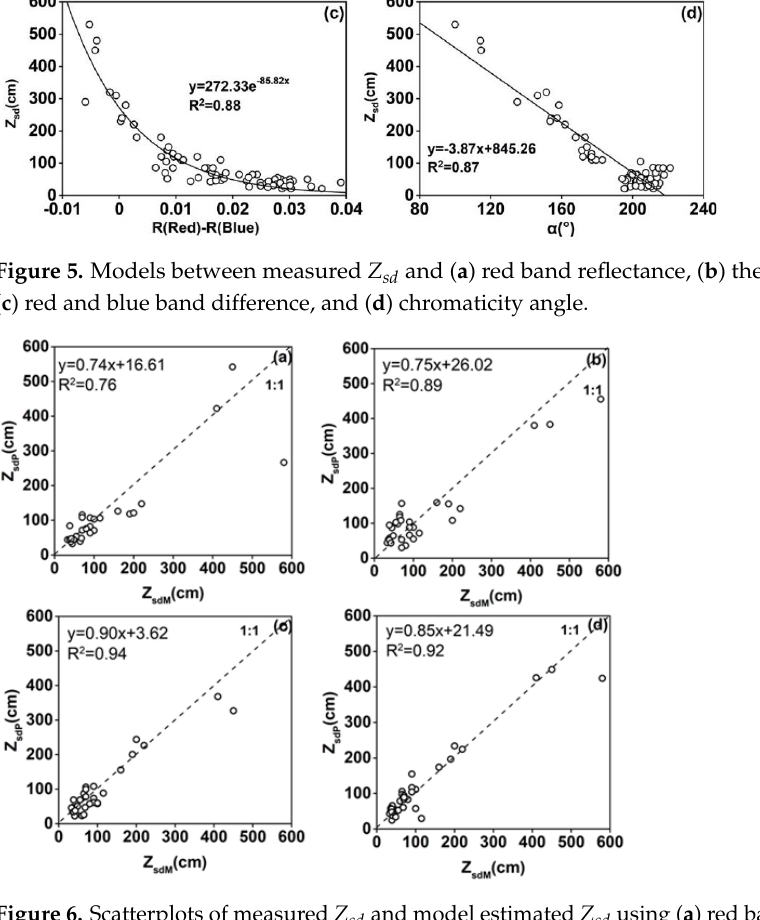
Figure 6. Scatterplots of measured Z sd and model estimated Z sd using ( a ) red band reflectance, ( b ) the green:red band ratio, ( c ) red and blue band difference, and ( d ) chromaticity angle. Table 5. Z sd model accuracy